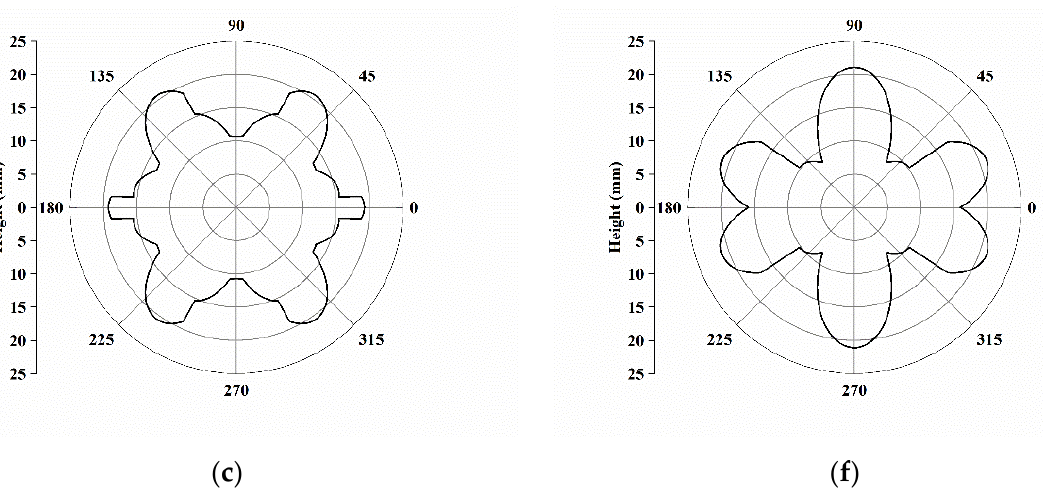
Figure 9. Cup height profiles as a function of the angle for texture components of ( a ) C, ( b ) S, ( c ) B, ( d ) Cube, ( e ) r-Cube, and ( f ) G predicted by assuming stress ratio = − 1 and hardening exponent = 1. The cup profile was simulated by varying the value of q for six components of C, S, B, Cube, r-Cube, and G to understand the influence of stress ratio q , as shown in Figure 10. The cup height for C, S, Cube, and r-Cube components were sensitive to the stress ratio q ; however, B and G components were insensitive to the stress ratio q . As the q value increased, it was observed to decrease in height at 90 ◦ for C, increase from 15 ◦ to 60 ◦ and decrease from 70 ◦ to 90 ◦ for S, increase at 0 ◦ and 90 ◦ but decrease at 45 ◦ for Cube, and increase at 15 ◦ and 90 ◦ but decrease at 60 ◦ for r-Cube. According to Van Houtte et al. [31] and Saimoto et al. [34], the range of stress ratio was between − 0.2 to − 0.3 in aluminum alloys at the flange region during deep drawing. Compared with the experimental deep-drawn profile, the stress ratio was set to − 0.3 because, as the annealing time increased from 0.5 to 20 h, the intensity of ears at 0 ◦ and 90 ◦ increased, whereas that at 45 ◦ decreased. Then, the profiles of cup height were predicted for six components of C, S, B, Cube, r-Cube, and G under the constant stress ratio of − 0.3 by modifying the hardening exponent from 0.2 to 1 in Equation (21) to know the effect of the hardening exponent, as shown in Figure 11. The ears for C, S, and B were at 45 ◦ , 30 ◦ and 55 ◦ , and 45 ◦ , respectively. These were at 0 ◦ and 90 ◦ , 10 ◦ and 89 ◦ , and 13 ◦ and 84 ◦ for Cube, r-Cube, and G, respectively. In addition, the formation of clear ears for all six components at m = 0.3 and the intensity of these ears increased with the increasing n value. The strain hardening exponent of Al-Mg alloys was close to 0.3 [39]. Consequently, the m value of 0.3 was selected. After optimizing the stress ratio of − 0.3 and the m value of 0.3, the profiles of cup height predicted for C, S, B, Cube, r-Cube, and G are shown in Figure 12. In the range from 0 ◦ –90 ◦ , the positions of ears for C, S, and B were found at 45 ◦ , 30 ◦ and 60 ◦ , meanwhile, at 50 ◦ , these for Cube, r-Cube, and G were at 0 ◦ and 90 ◦ , at 5 ◦ and 90 ◦ , and 15 ◦ and 90 ◦ , respectively. In general, the significant ears for C, S, and B were located at 45 ◦ , whereas, Cube, r-Cube, and G were located at 0 ◦ and 90 ◦